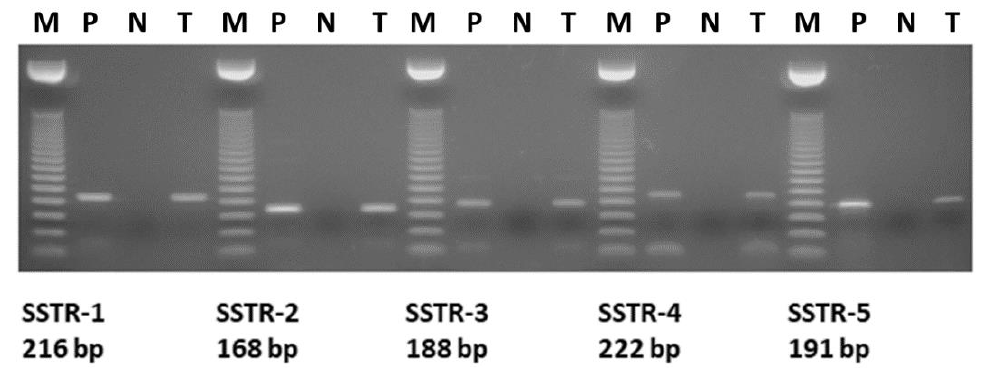
Figure 1. Representative RT-PCR analysis of mRNA for somatostatin receptor (SSTR) subtypes (SSTR-1–5) in one representative pediatric Hodgkin lymphoma specimen. M: DNA marker 50 bp; P: Positive control (human bladder carcinoma); N: Negative template control; T: Pediatric tumor specimen (patient number 4, Hodgkin lymphoma) positive for all 5 SSTR subtypes (SSTR-1–5).